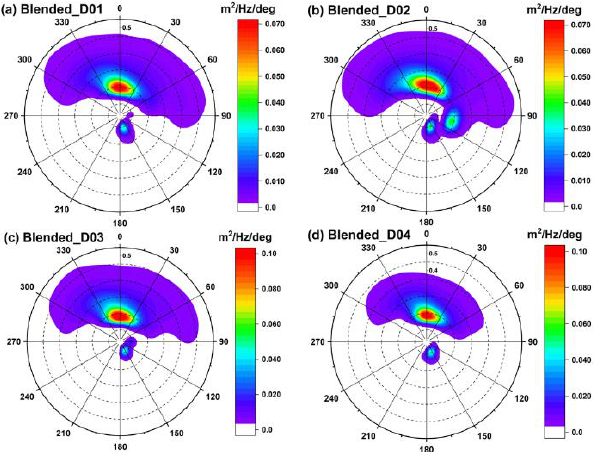
Figure 22. Comparison of the directional wave spectra at the Taitung wave buoy at 00:00 on 17 September 2016, using the four computational domains ( a – d ) and blended wind fields.